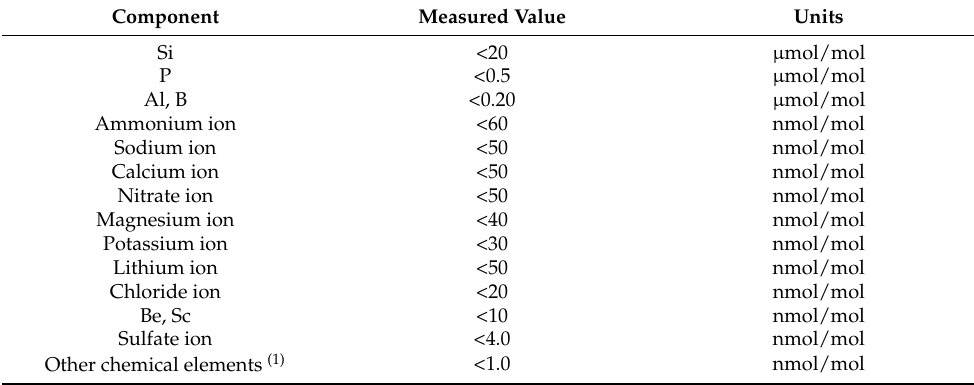
Table 6. Results of elemental analysis from hydrogen gas. The hydrogen was passed through a filter that was then analysed for chemical elements. (1) Other chemical elements include V, Cr, Mn, Fe,